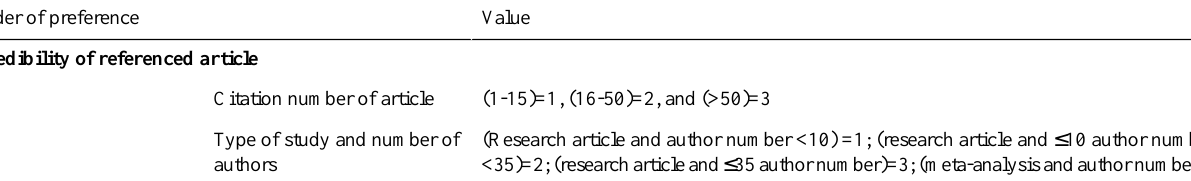
Table 2. Evidence degree assignment criteria for clinicogenomic